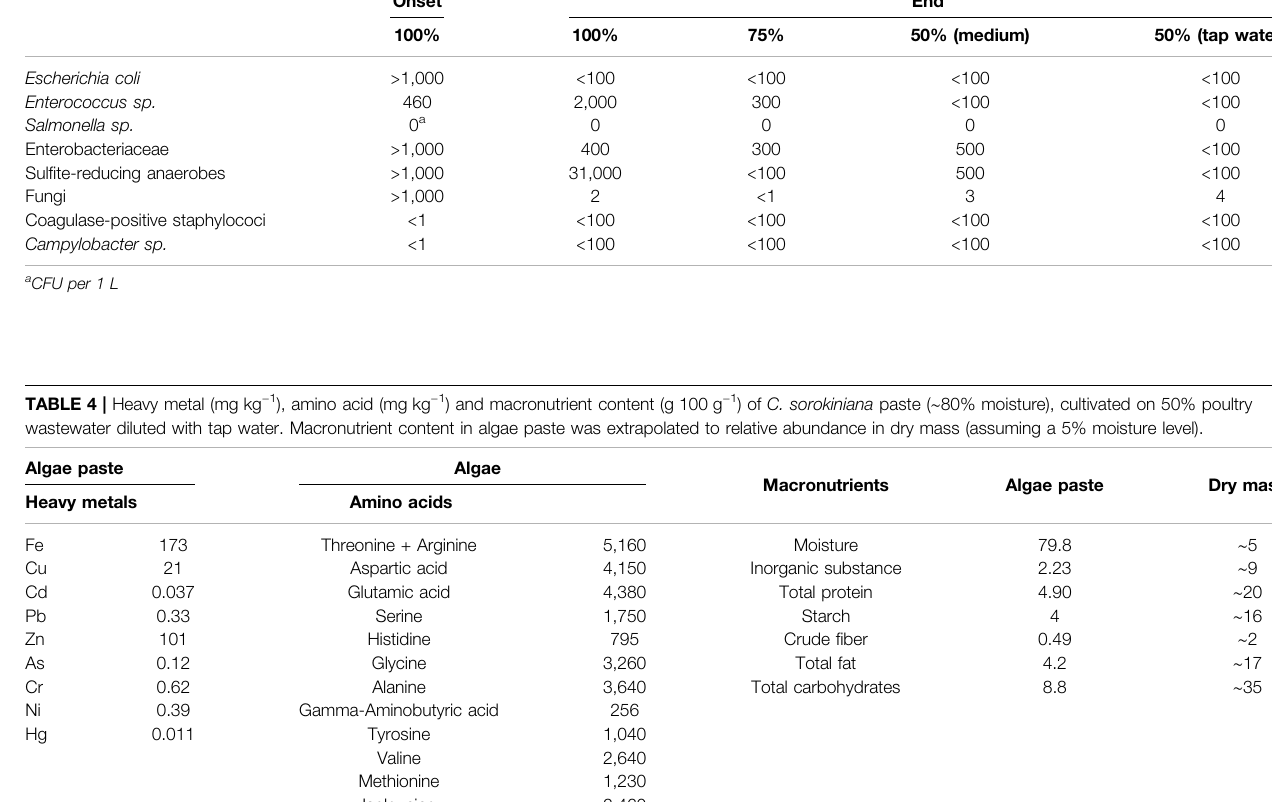
TABLE 3 | Abundance of major pathogen groups per experimental condition (non-sterilized wastewater dilutions 50 – 100%) at the onset and end of the experiment. Values are expressed as CFU per 100 ml.